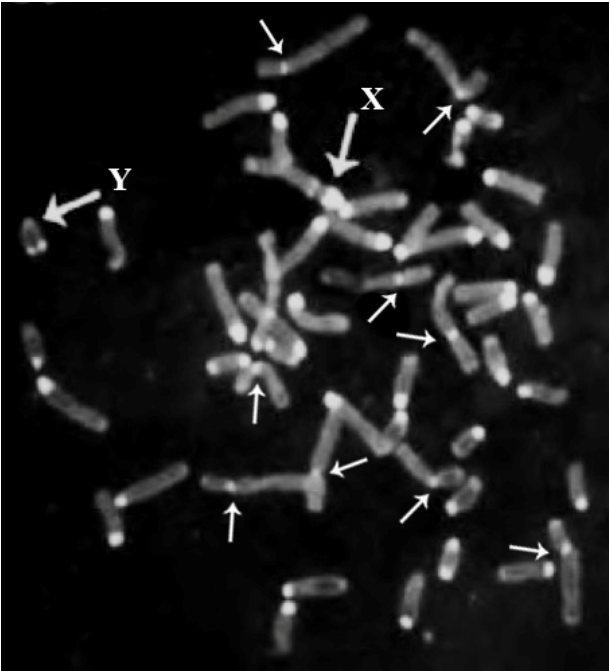
Figure 2. CBA banding in a river buffalo male metaphase. Note the larger HC block (C-bands) in the X chromosome also showing a proximal positive C-band. The Y chromosome has a telomeric positive C-band, making it easily distinguishable from other autosomes showing all of them to be centromeric C-band positive. Note the small amounts of HC (C-bands) in the biarmed pairs (small arrows). With analyses of both chromosome banding comparisons and FISH mapping